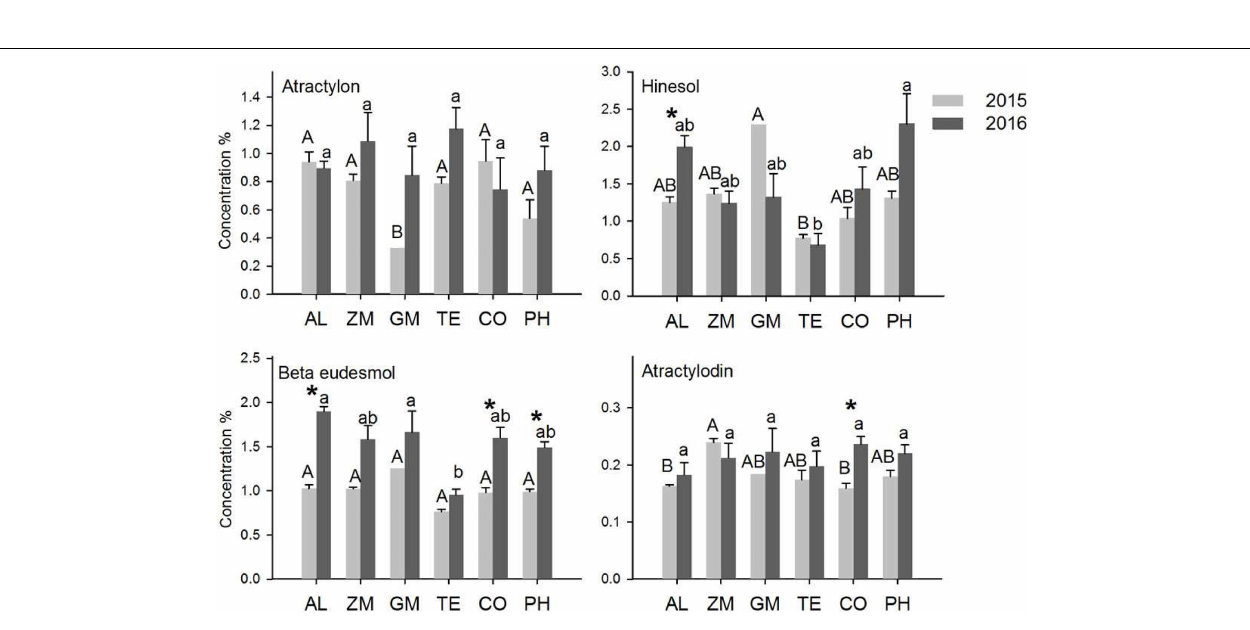
FIGURE 4 | The effect of different intercropping treatments on the concentrations of four volatile oils from A. lancea in 2015 and 2016. Different capital (2015) and lowercase (2016) letters indicate significant differences at the 5% significance level, and asterisks indicate significant differences between 2015 and 2016 within individual